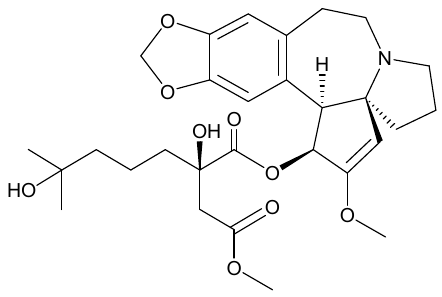
Figure 10. Homoharringtonine. Figure 10.